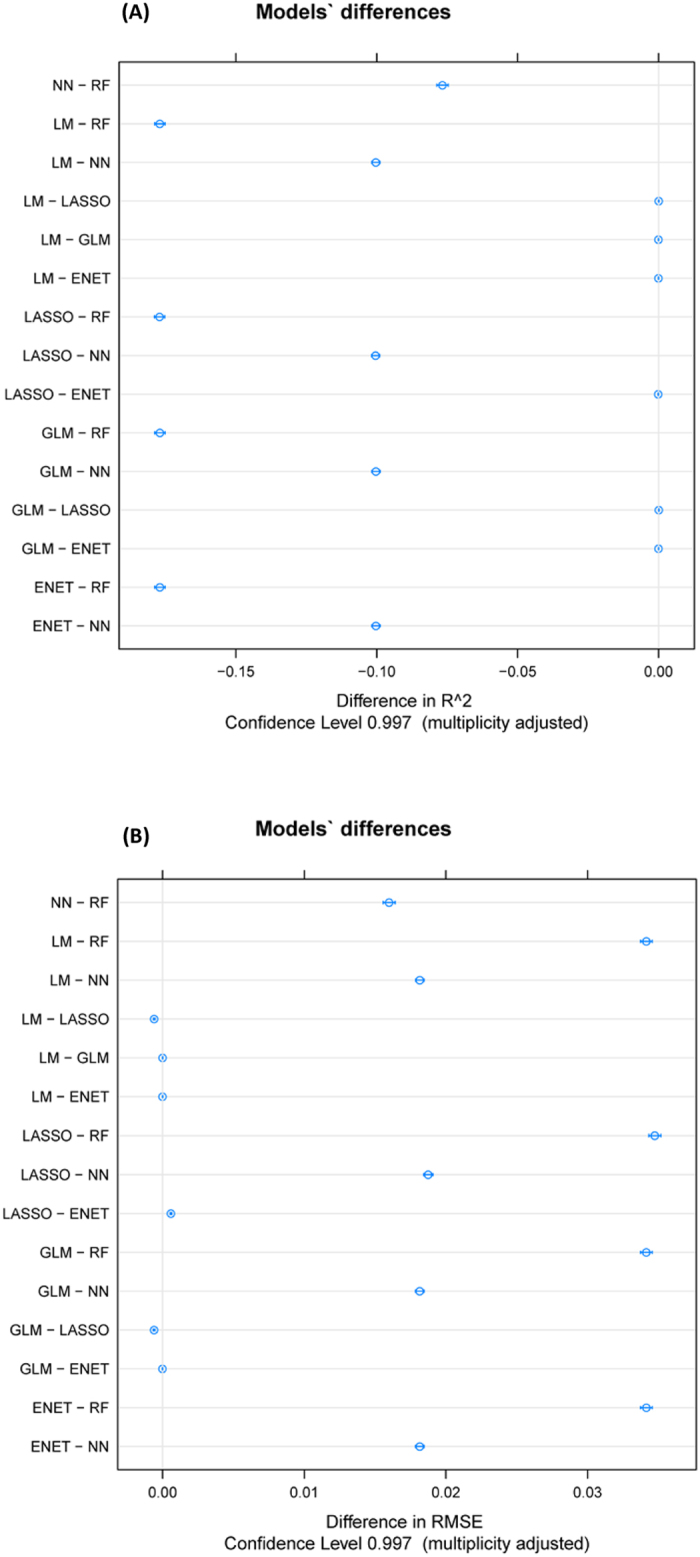
RRegrs pairwise model comparisons of R2test and RMSEtest.The average performance value (dot) with two-sided confidence limits as computed by Student’s t-test with Bonferroni multiplicity correction.